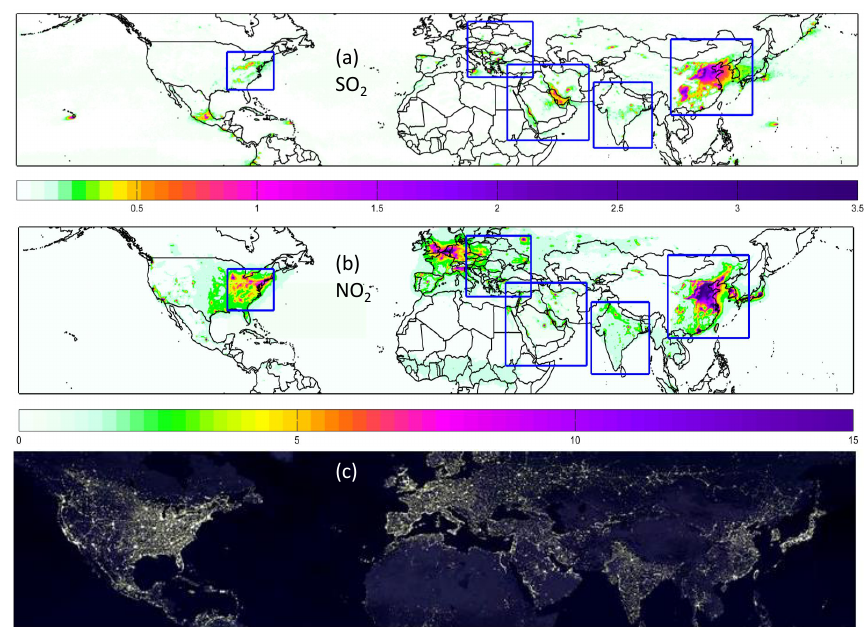
Figure 1. OMI-derived maps of PBL SO 2 in Dobson units (DUs) (a) and tropospheric NO 2 columns in [10 15 moleculescm − 2 ] (b) for 2005–2007 show enhanced pollution levels around major cities and industrial centers, seen also in the “Earth at Night” (city lights) map (c) , courtesy of the Aura EPO